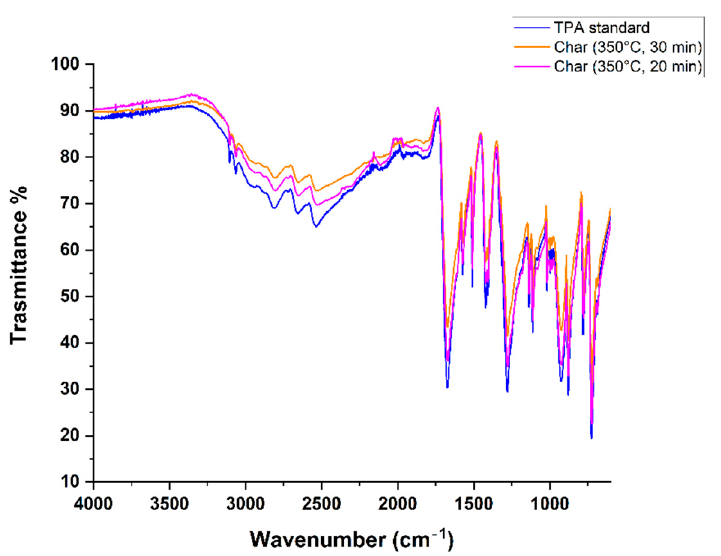
Figure 6. IR spectra of the solids obtained from test 1 (orange; 345 °C, 30 min), from test 2 (magenta; 345 °C, 20 min), and TPA standard (blue).